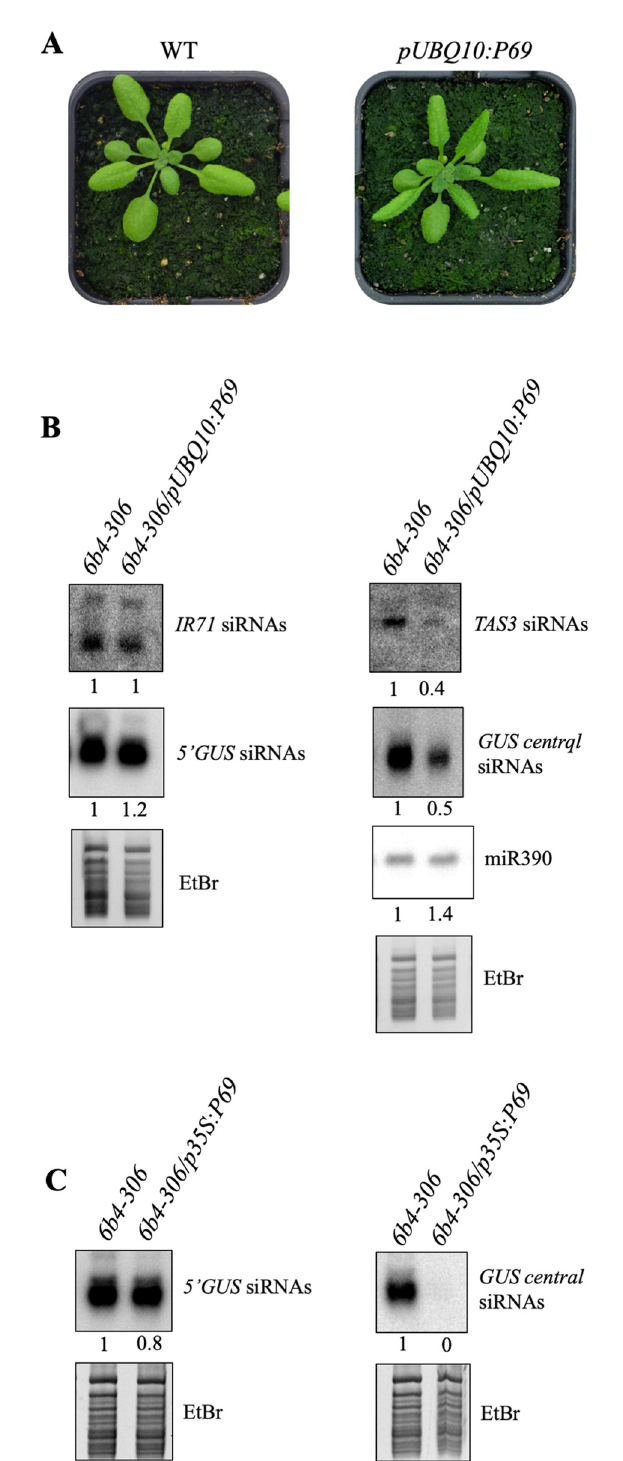
Fig 4. The TYMV protein P69 inhibits the production of PTGS secondary siRNAs. A) Phenotype of wild-type plants and transgenic lines carrying a pUBQ10 : P69 construct. Downward leaf curling is typical of the absence of TAS3 siRNAs. B) Accumulation of miR390, TAS3 and IR71 endogenous siRNAs and GUS primary and secondary siRNAs (using 5’GUS and central GUS probes, respectively, see Fig 2A) in control or transgenic plants transformed with the pUBQ10 : P69 construct. EtBr staining is shown as loading control. C) Accumulation of GUS primary and secondary